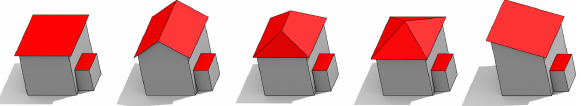
Figure 5: Different types of roofs (flat, gabled, hipped, pyrami- dal, and shed) fitted on the same building, with the automatically adjusted walls. This image shows the LOD2 (orthogonal view), and it also features an example of a building part.